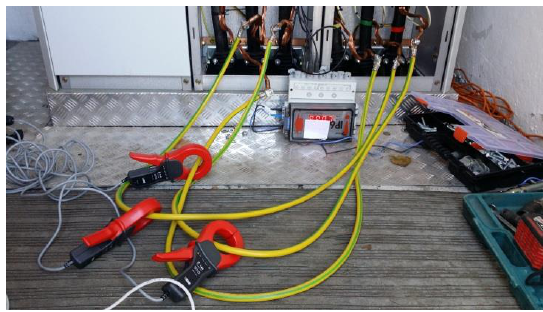
Figure 10. Sheaths unearthed and uncrossed in Substation 2.